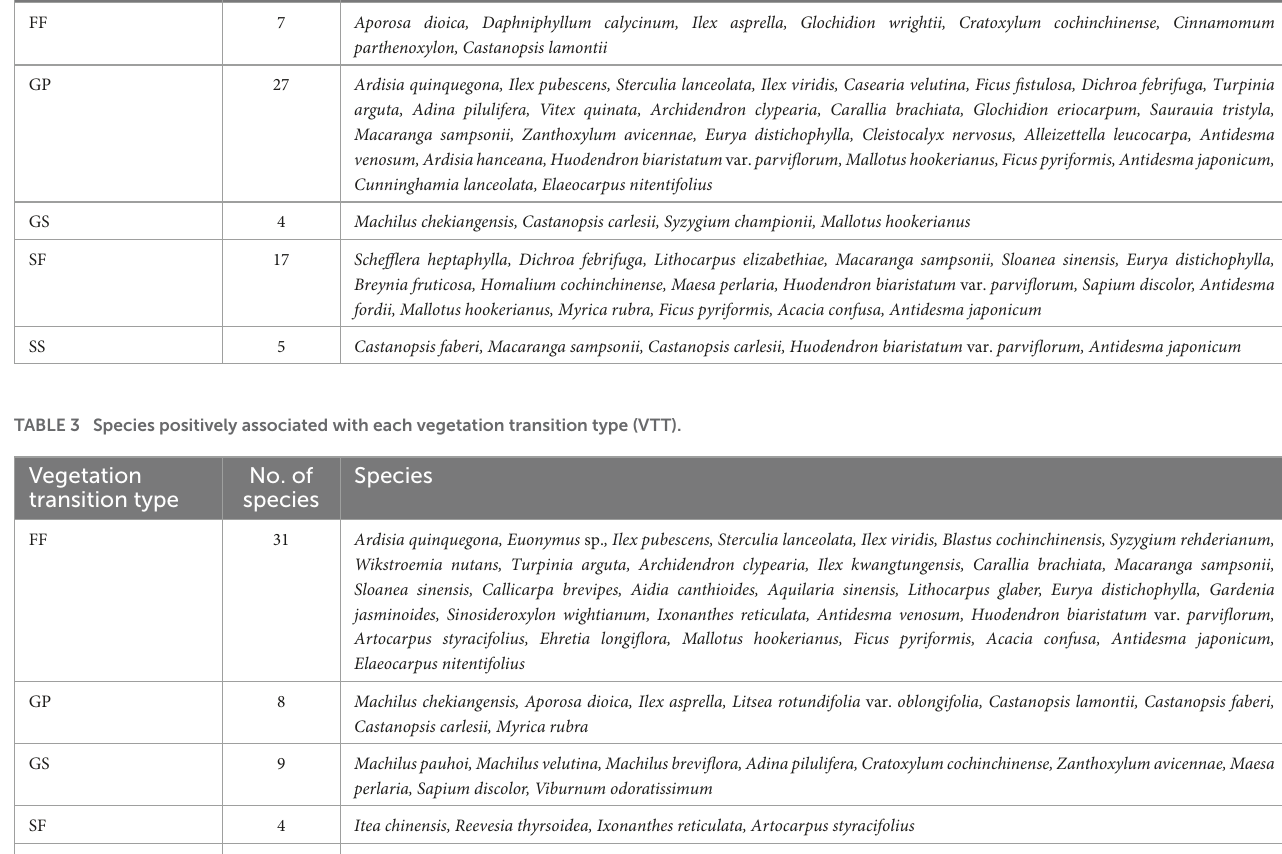
TABLE 2 Species negatively associated with each vegetation transition type (VTT). Vegetation transition type